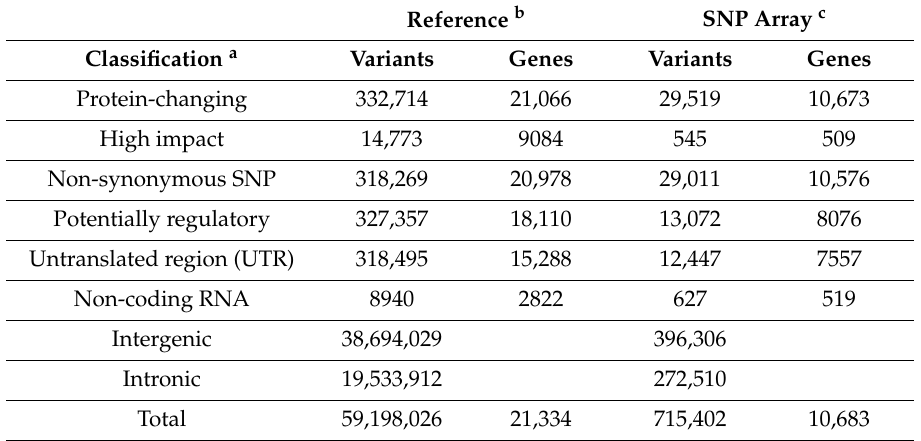
Table 2. Functional classification of variants detected in the cattle haplotype reference